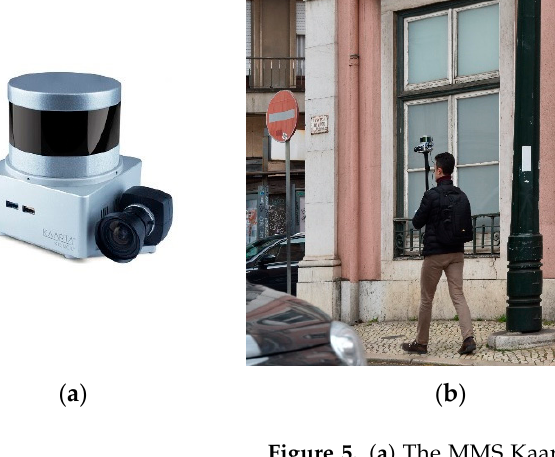
Figure 5. ( a ) The MMS Kaarta Stencil 2–16; ( b ) An operator using the MMS detecting the urban environment; ( c ) Top view of the 3D point cloud and closed loop trajectories (red lines) made with the MMS. Table 3. Data acquisition parameters.